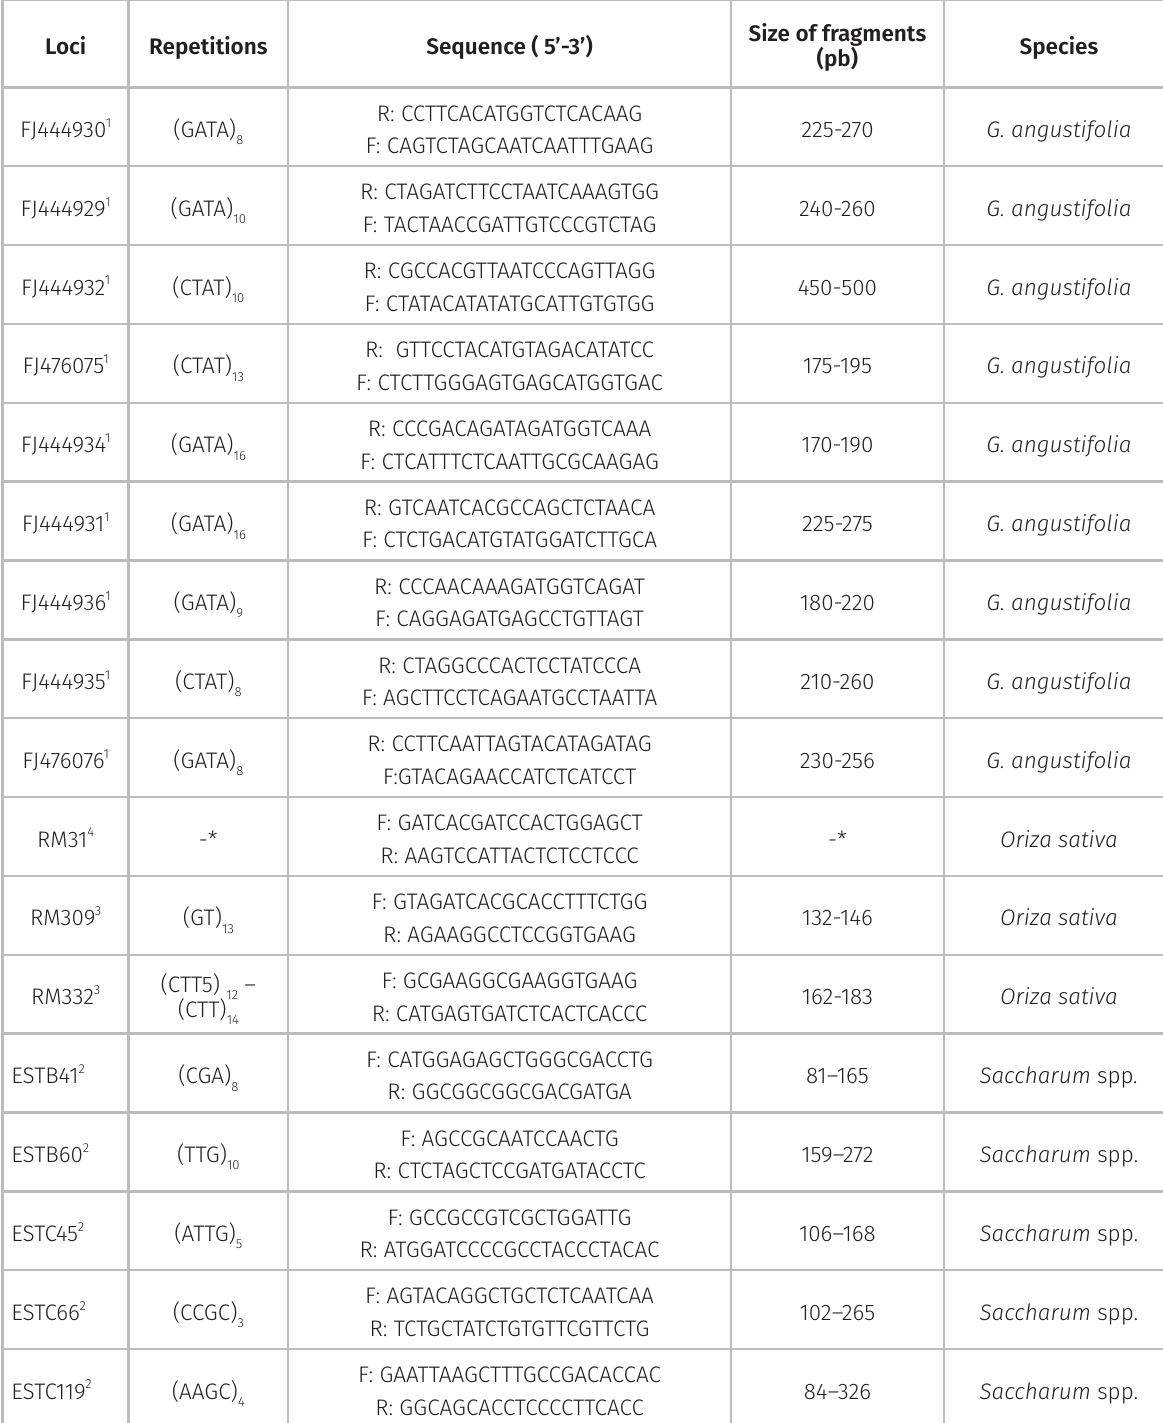
Table II. SSR loci developed by Pérez-Galindo et al. (2009) 1 , Oliveira et al. (2009) 2 Temnykh et al. (2000) 3 and Chen et al. (1997) 4 used for the analysis of transferability in Guadua aff. chaparensis and G. aff. Lynnclarkiae